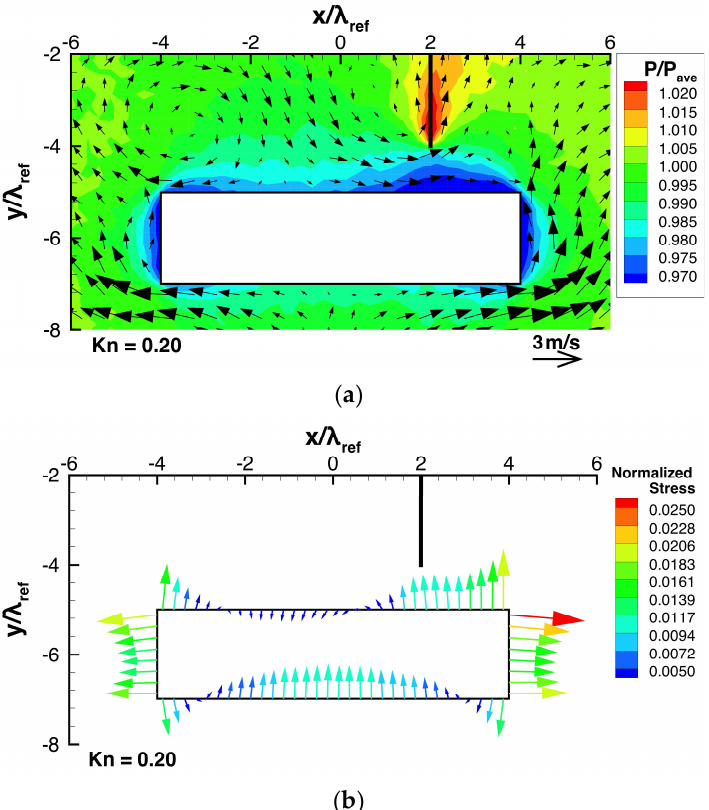
Figure 6. ( a ) Pressure and flow distributions around the beam and ( b ) stress distributions on the beam surfaces, when the beam is placed close to a heated thin plate mounted on a substrate, at Kn = 0.2 .